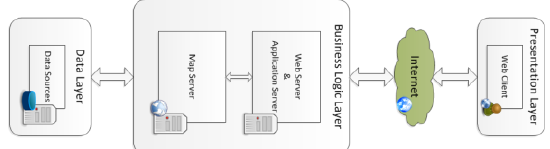
Figure 3. Architecture of the developed PPGIS